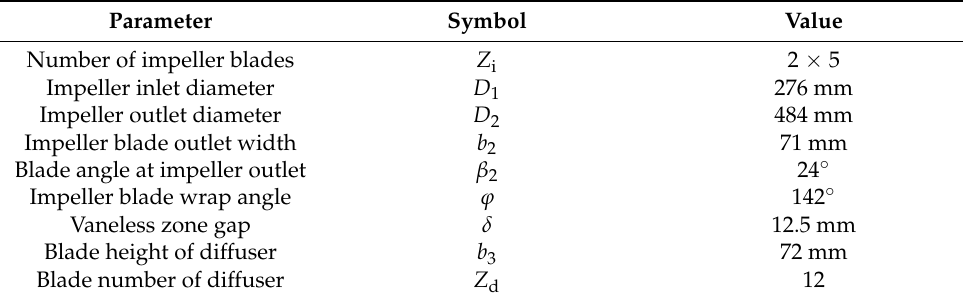
Figure 2. Real impeller. Table 1. The main design and performance parameters (pump mode, design Table 1. The main design and performance parameters (pump mode, design point).